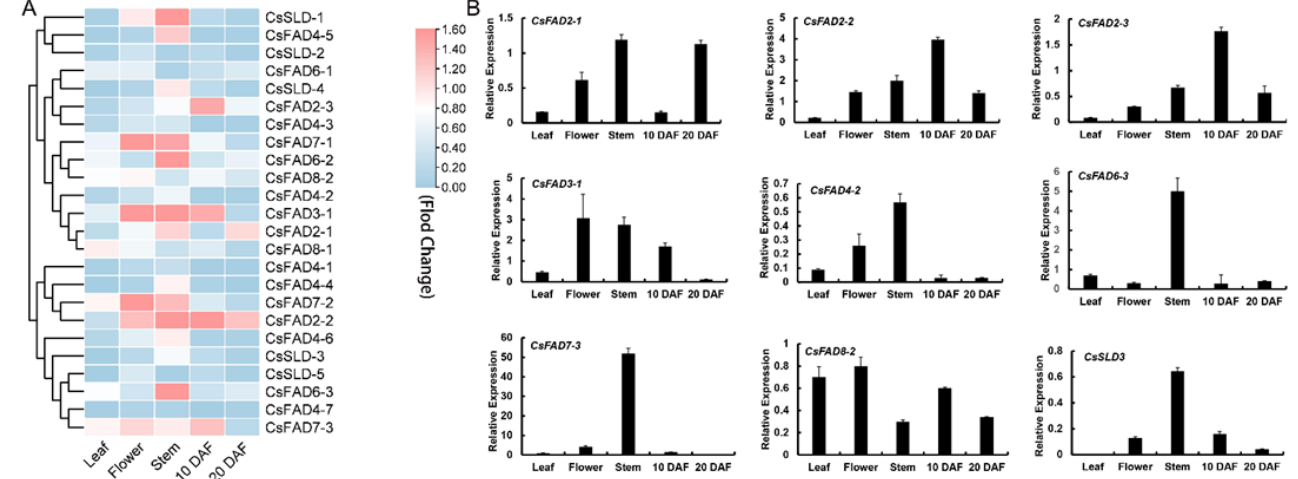
Figure 4. Expression profiles of CsFAD family genes in different Camelina tissues and organs: ( A ) the normalized expression levels of the hierarchical clustering of 24 CsFAD genes in 5 tissues (leaves, stem, flower, seeds 10 days after flowering (DAF), and seeds 20 days after flowering (DAF)). The transcription level was graded color scale from green to red. Expression data were obtained from the Camelina genome database. The normalized expression level of CsFAD genes is expressed in the form of log2 values; ( B ) qRT-PCR profiles of CsFAD genes in different Camelina tissues and organs. The expression level of the CsActin gene in Camelina was normalized as “1”. Vertical bars indicated the standard error of the mean. Data are shown as means ± SD of three replicates (n = 3 ×